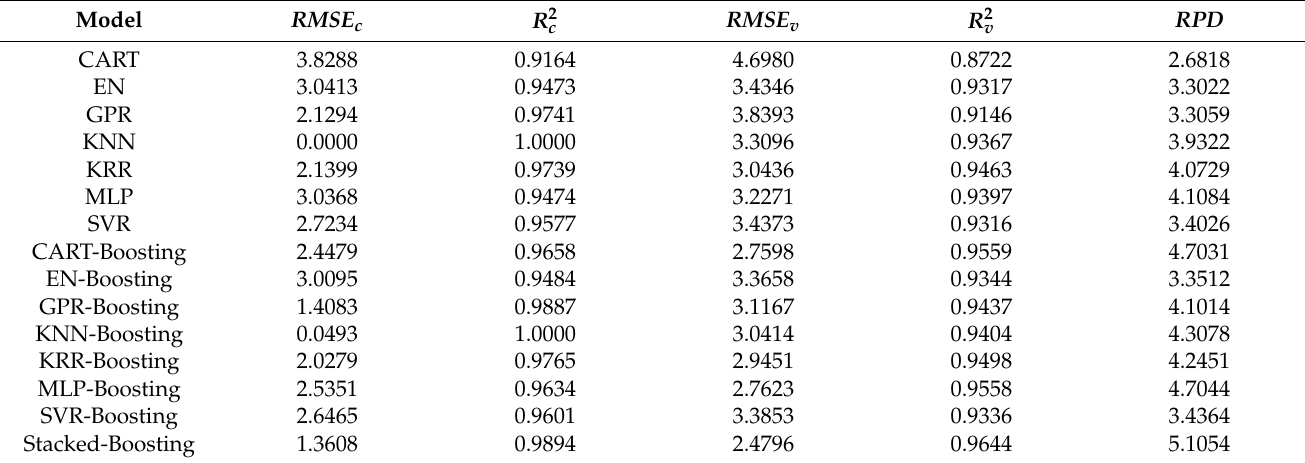
Table 4. Modeling Table 4. Modeling results.